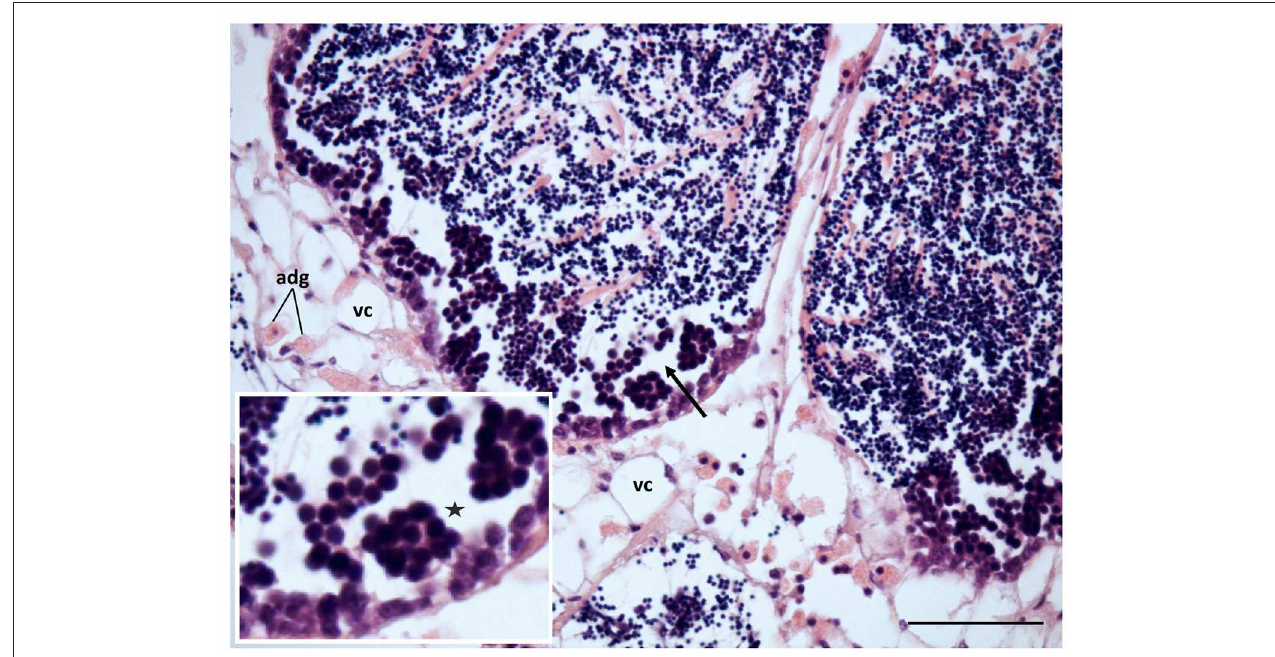
FIGURE 7 | Gametogenesis reactivation and recovery of the connective tissue in mussels transplanted to non-toxic conditions after exposition to 60mg L − 1 tar for 17 days. adg, Adipogranular cells; vc, vesicular cells; discontinuity in the germline (*), and aggregates of large and pyknotic spermatocytes (arrow) can still be observed. Scale bar: 50 µ m. Inset: 2x magnification in base